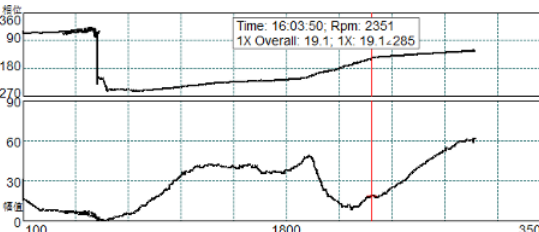
Fig. 4. Bode diagram of 9 watt liter speed.